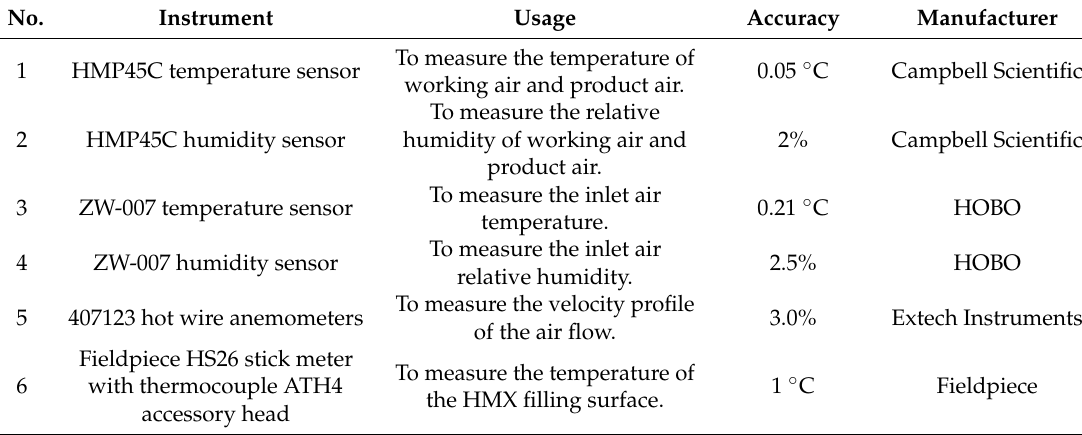
Table 4. Details of instrumentation for the experimental testing in